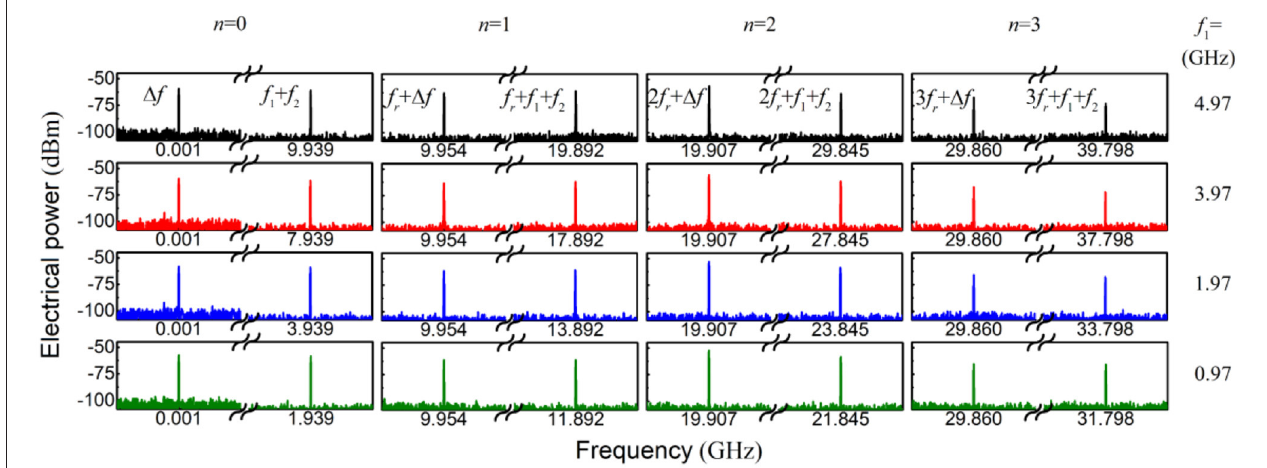
FIGURE 2 | Measured electrical spectra around nf r + f 1 + f 2 and nf r + 1 f in the initial ( n = 0), first ( n = 1), second ( n = 2) and third ( n = 3) segment under different two-tone